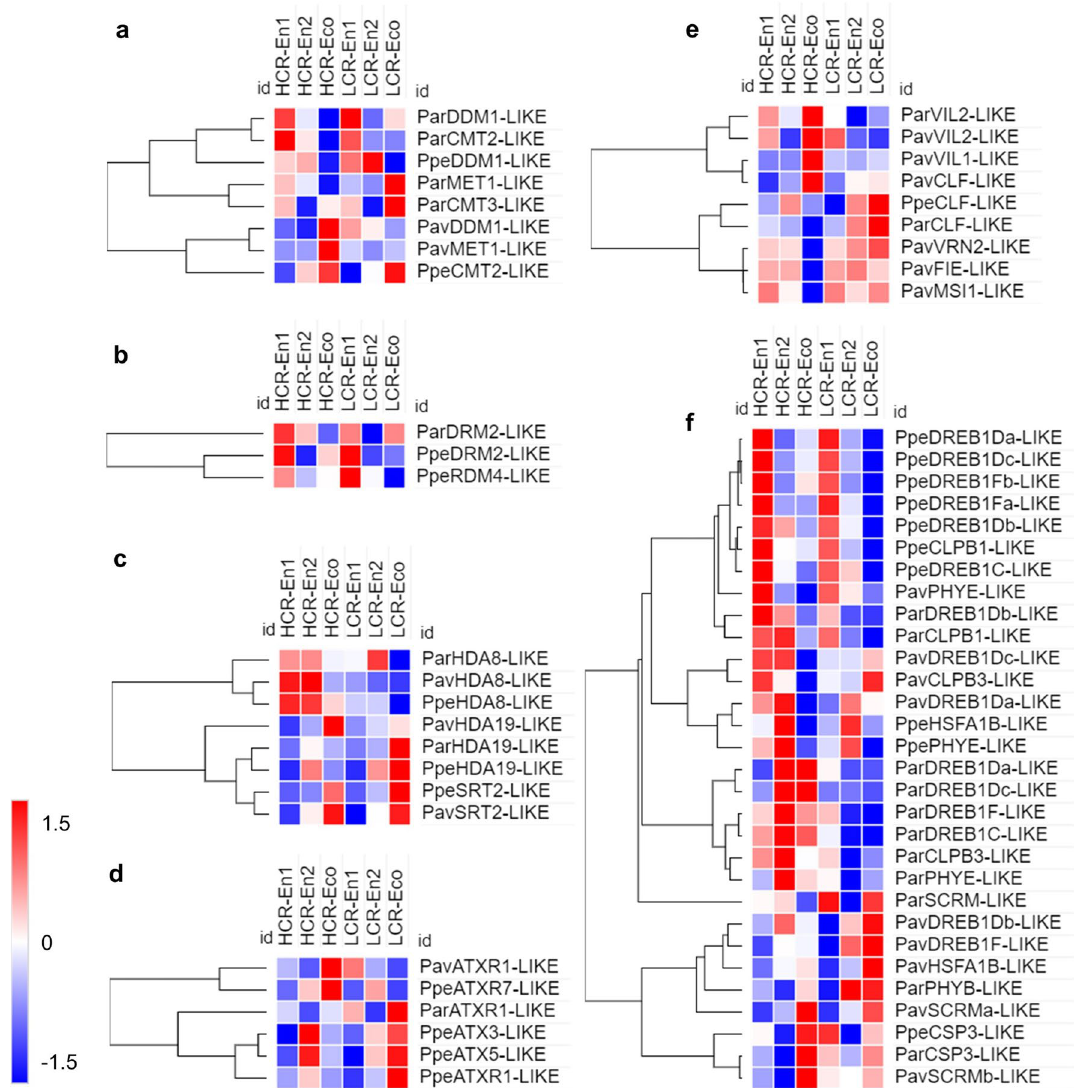
Figure 5. Expression profiles of differentially expressed genes coding for epigenetic regulators: DNA methyltransferases ( a ), gene of RdDM pathway ( b ), histone deacetylases HDA ( c ) and histone methylases of ATX family ( d ) and Polycomb Repressive Complex 2 (PRC2) components ( e ). ( f ) represents the heat-map of genes regulated by light and temperature during endodormancy entrance (En1), endodormancy release (En2) and ecodormancy (Eco) in peach (Ppe), apricot (Par) or sweet cherry (Pav). For each species HCR and LCR genotypes are considered. z-score scaled DEGs expression levels are reported in red to blue color scale, corresponding to higher and lower expression,